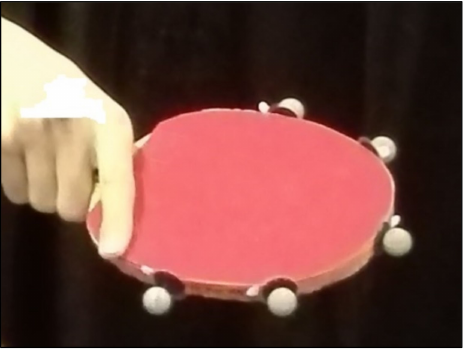
Figure 1. The shake hands grip used to hold the racket and marker placement on the table tennis